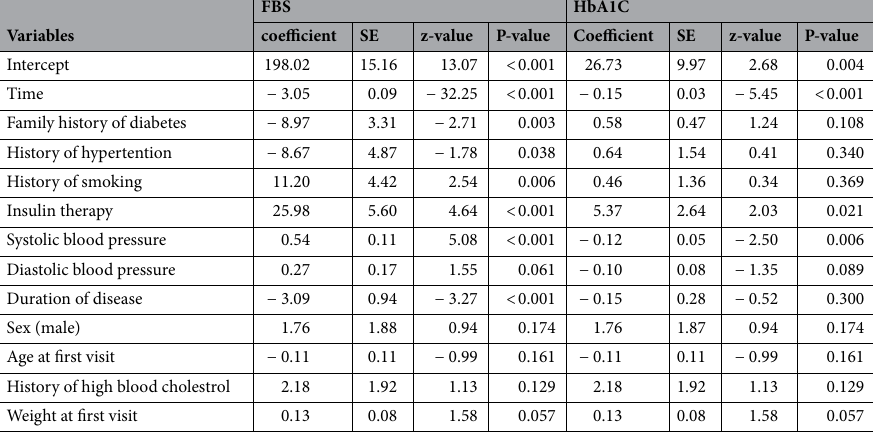
Table 3. Results of fitting Model III (final model) for estimating regression